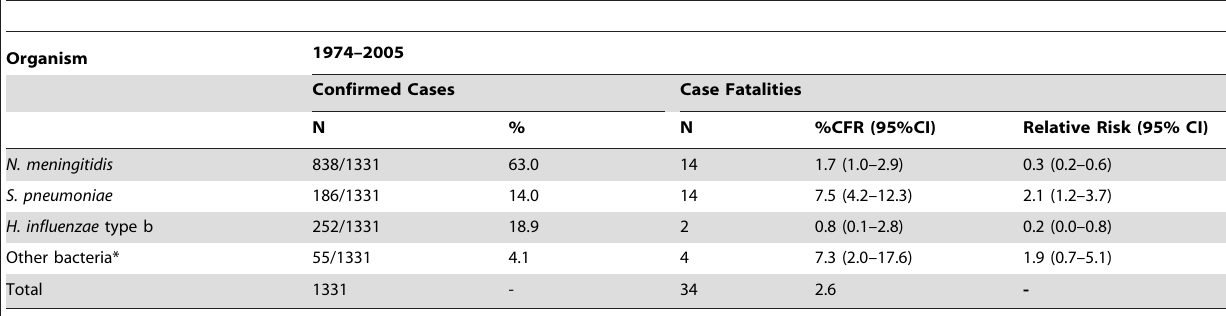
Table 1. Number of confirmed cases and Case Fatality Rates (CFR) of the most common aetiological pathogens of meningitis throughout